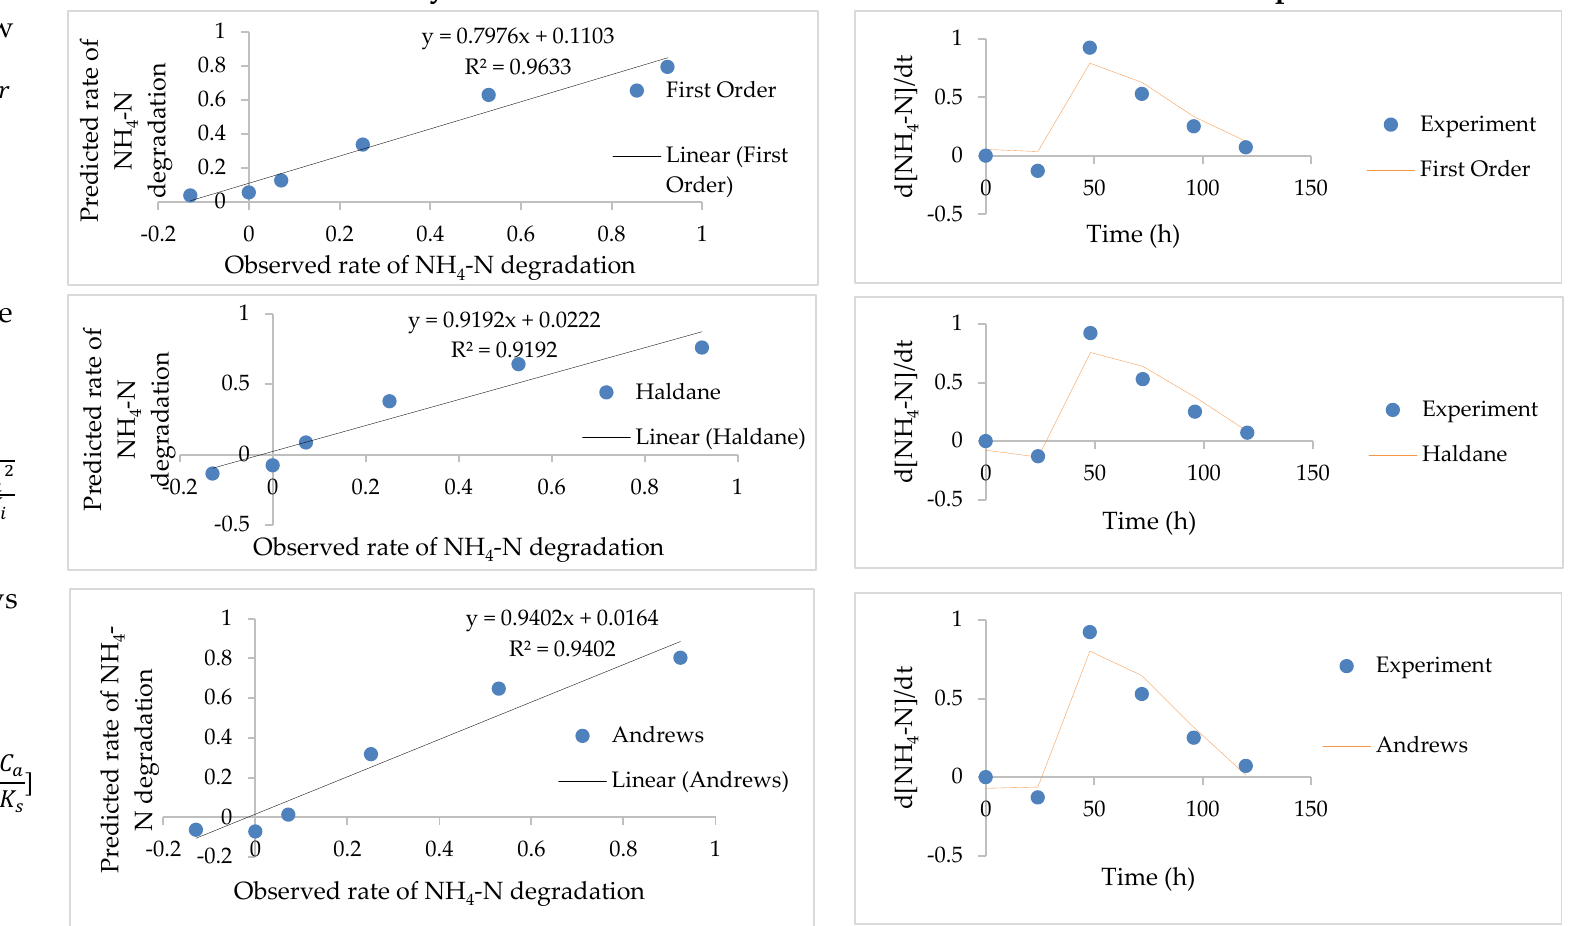
Figure 2. Parity plots of predicted values versus experimental values. Assimilations of the model data into NH 4 -N degradation experimental data (Rate law, Haldane, and Andrew).